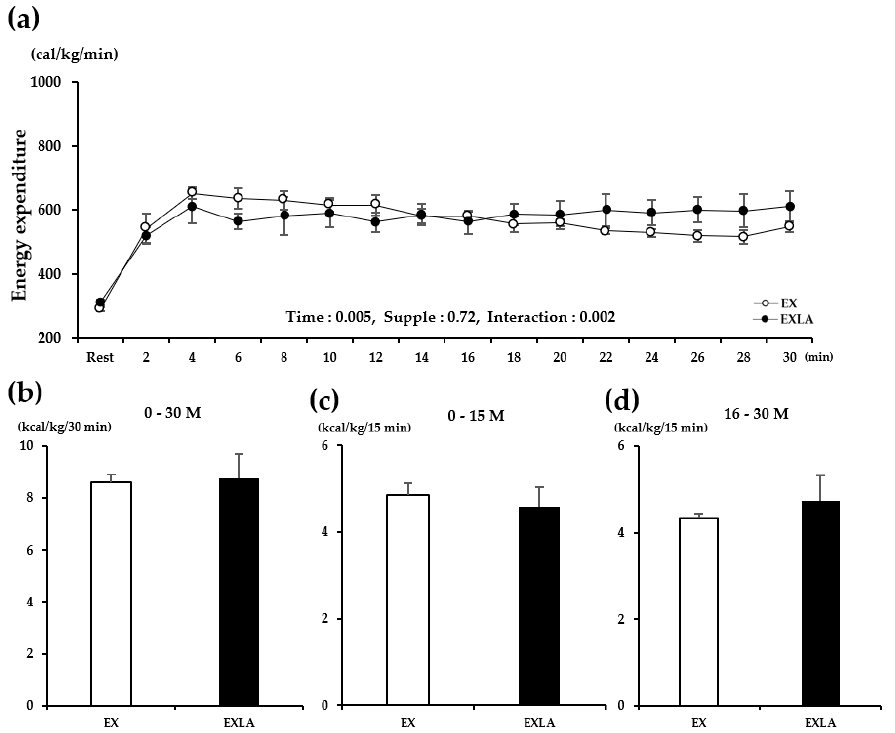
Figure 5. Changes in EE during exercise. ( a ) EE changes over time for 30 min; ( b ) total EE for 30 min; ( c , d ) total EE for 0–15 min (0–15 M) and 16–30 min (16–30 M), respectively. Supple, supplement effect; Inter, interaction effect; EE, energy expenditure; EX, exercise control group; EXLA, exercise with lactate intake group. Values represent the mean ± standard deviation ( n = 8).